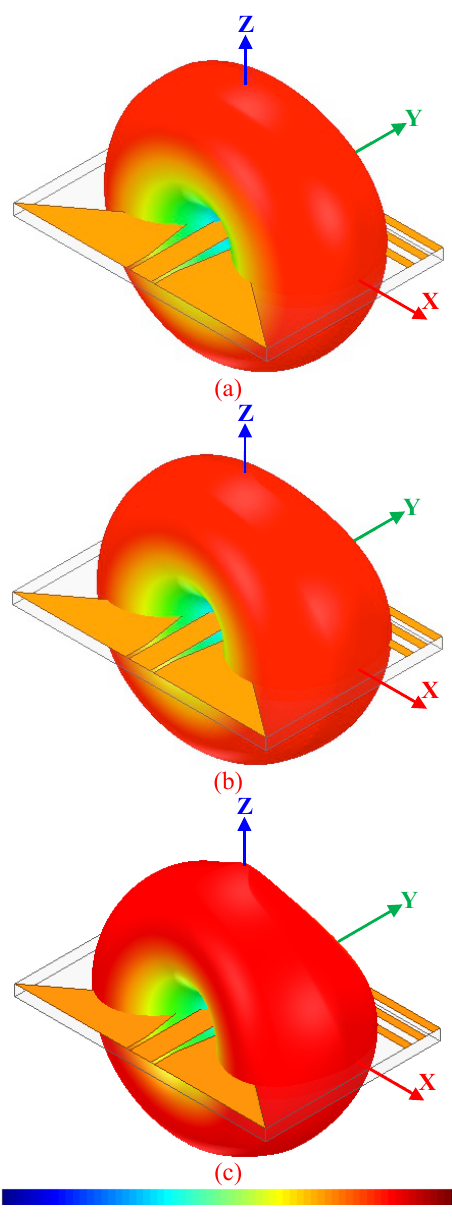
FIGURE 13. Simulated normalized 3D radiation patterns at: (a) 4 GHz, (b) 8 GHz, (c) 12 GHz. TABLE II. A Comparison with Other CPW-Fed UWB Antennas